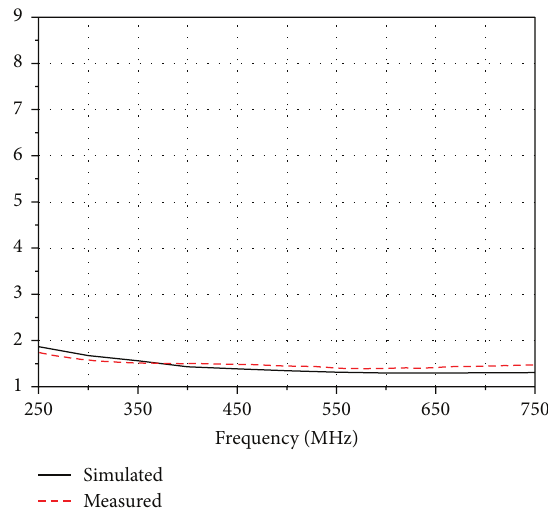
Figure 5: Simulated and measured VSWR of the antenna